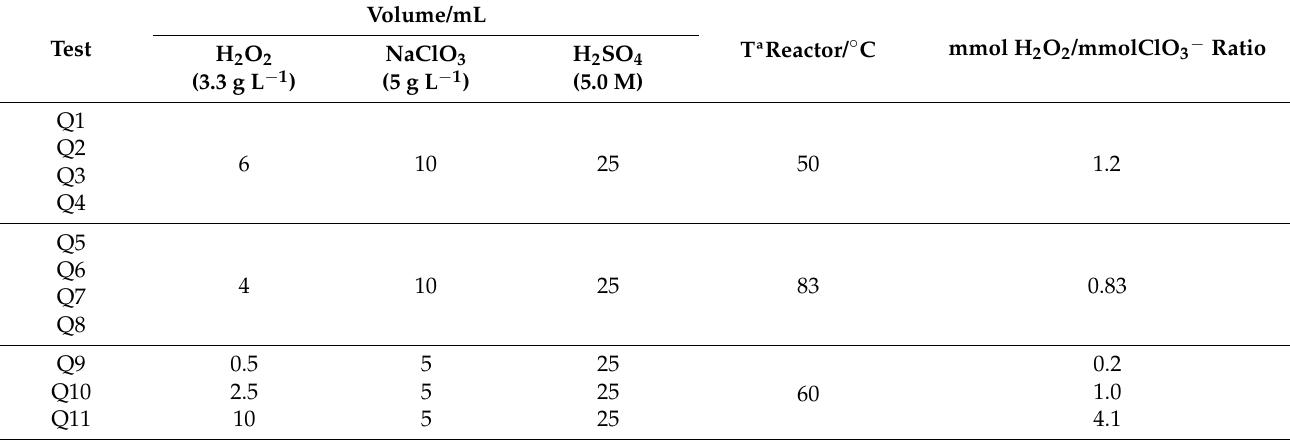
Table 1. Experimental conditions for the chemical production of chlorine